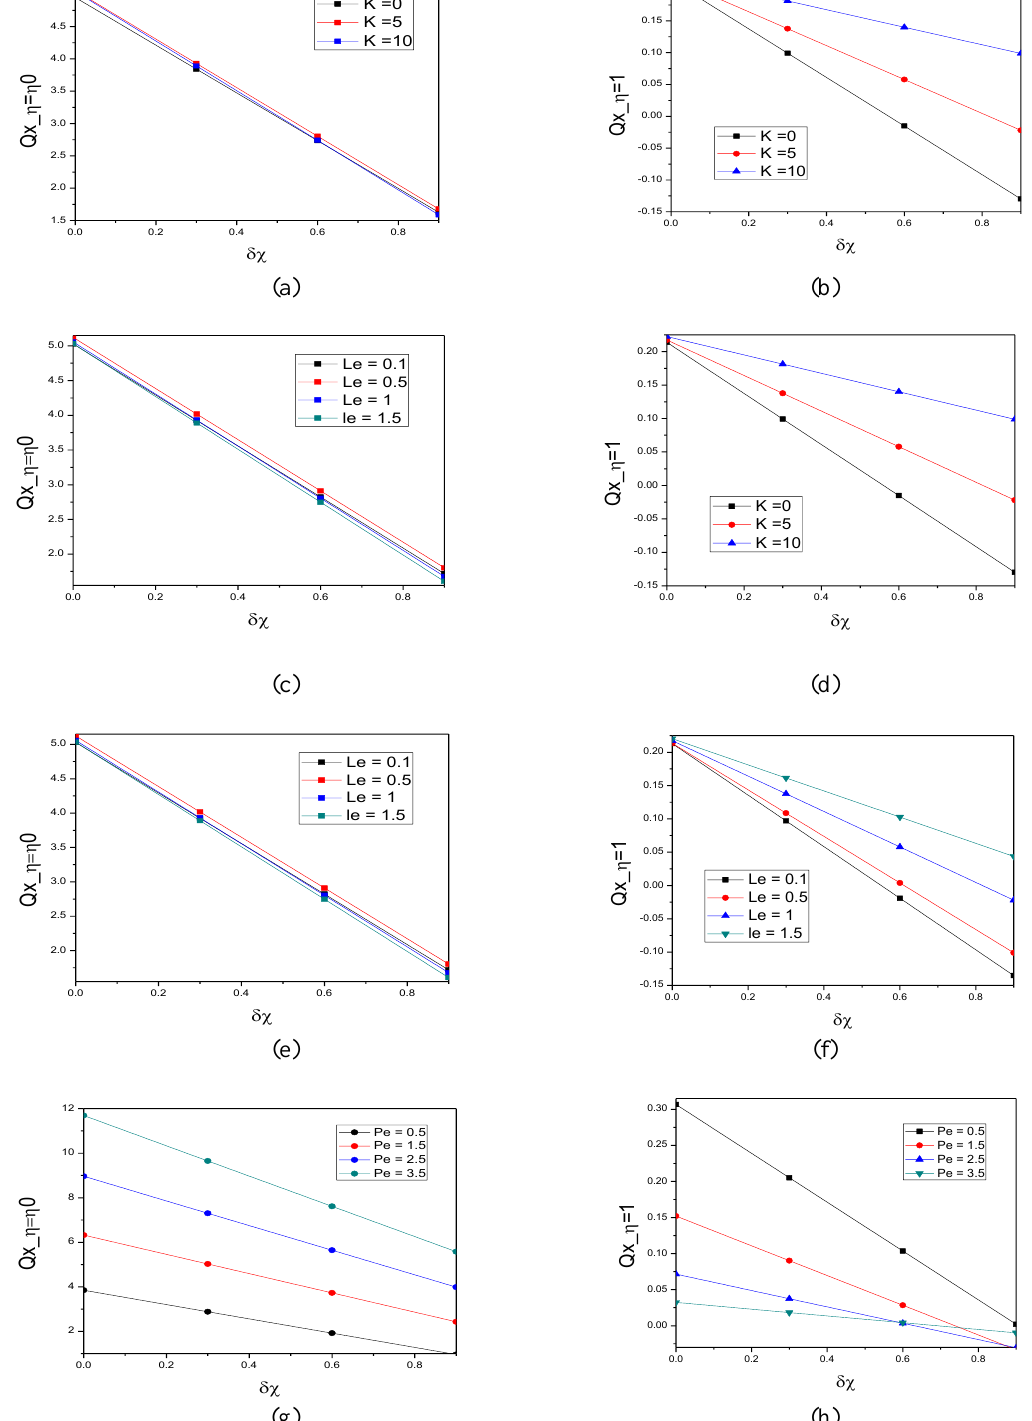
with 𝛿𝜒 w.r.t K, 𝐿𝑒 , 𝑃𝑟 and 𝑃𝑒 at the bounadries of inner and outer 𝑥